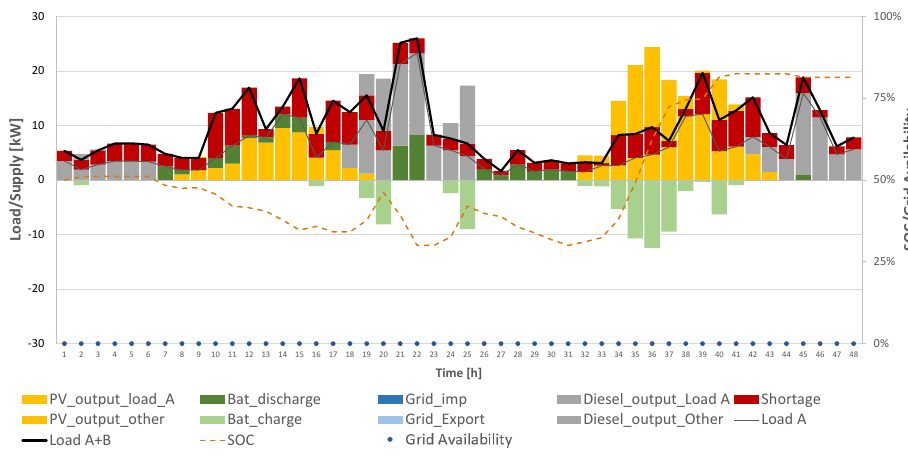
Figure 11. Optimal dispatch for dry season off-grid mini-grid.